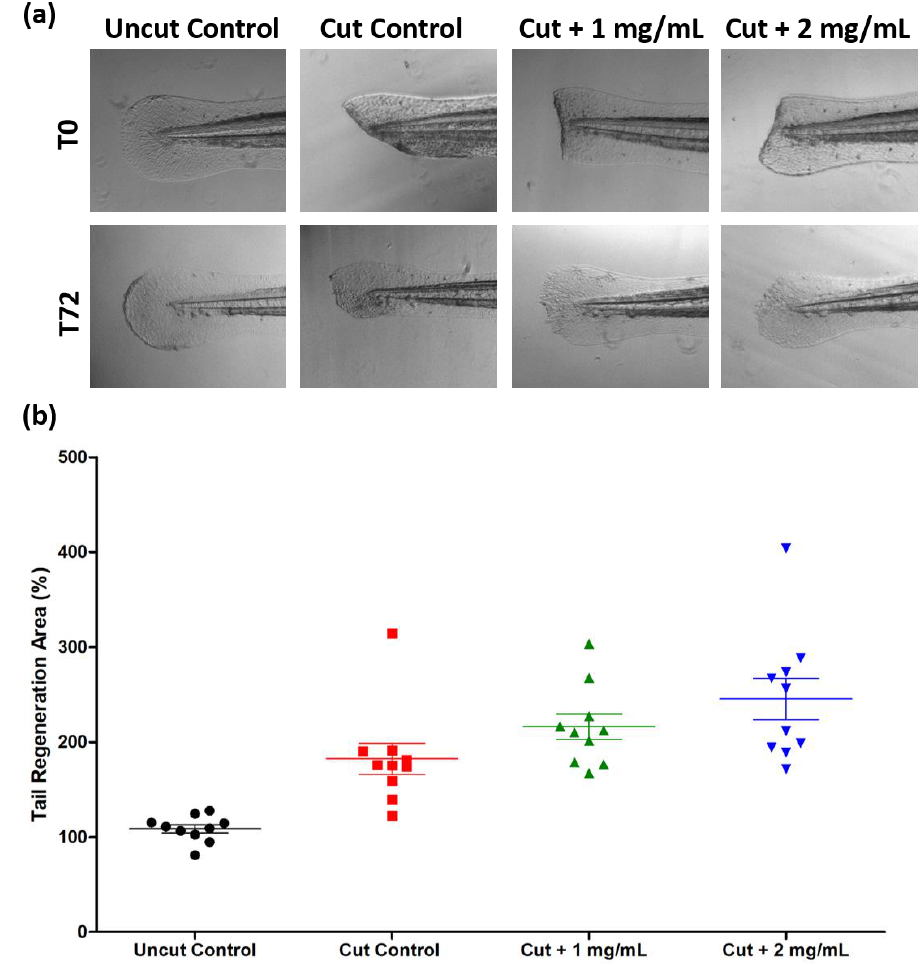
Figure 8. In vivo wound healing in zebrafish embryos. At 3 days post fertilization (dpf), zebrafish caudal tail fins were transected (or not), treated (or not) with 1 and 2 mg/mL of MOE/SA/PVA scaffold suspension (S5) and then images were taken at 0 to 72 h of regeneration after treatment using EVOS M5000 microscopy ( a ). Representative graph of the tail regeneration length capacity of the S5 scaffold when compared with the control ( b ).